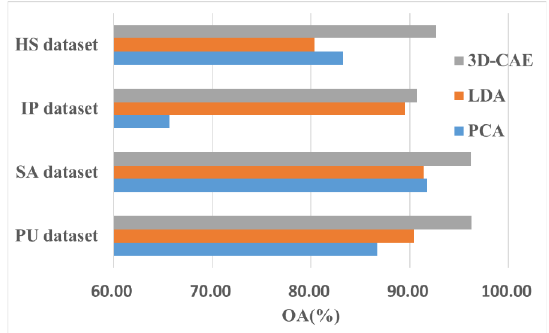
Figure 12. Effectiveness of the 3D-CAE.